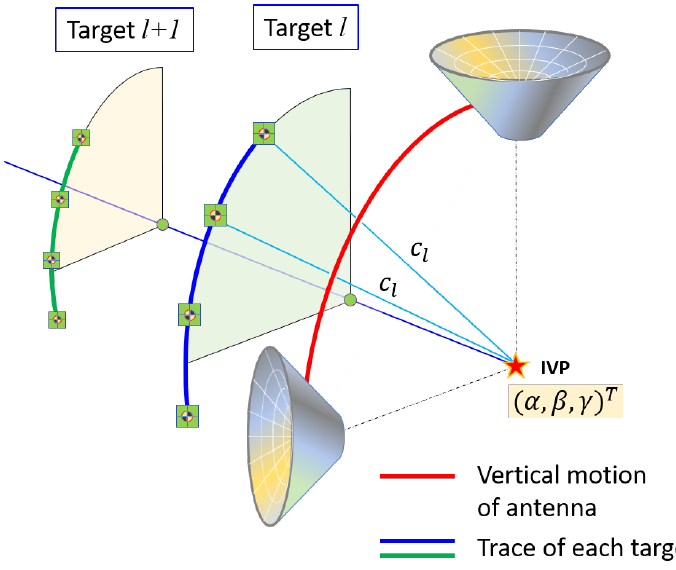
Figure 4. Rotation in elevation (i.e., in a vertical plane). Each quarter circle is part of a cone, with the apex at the